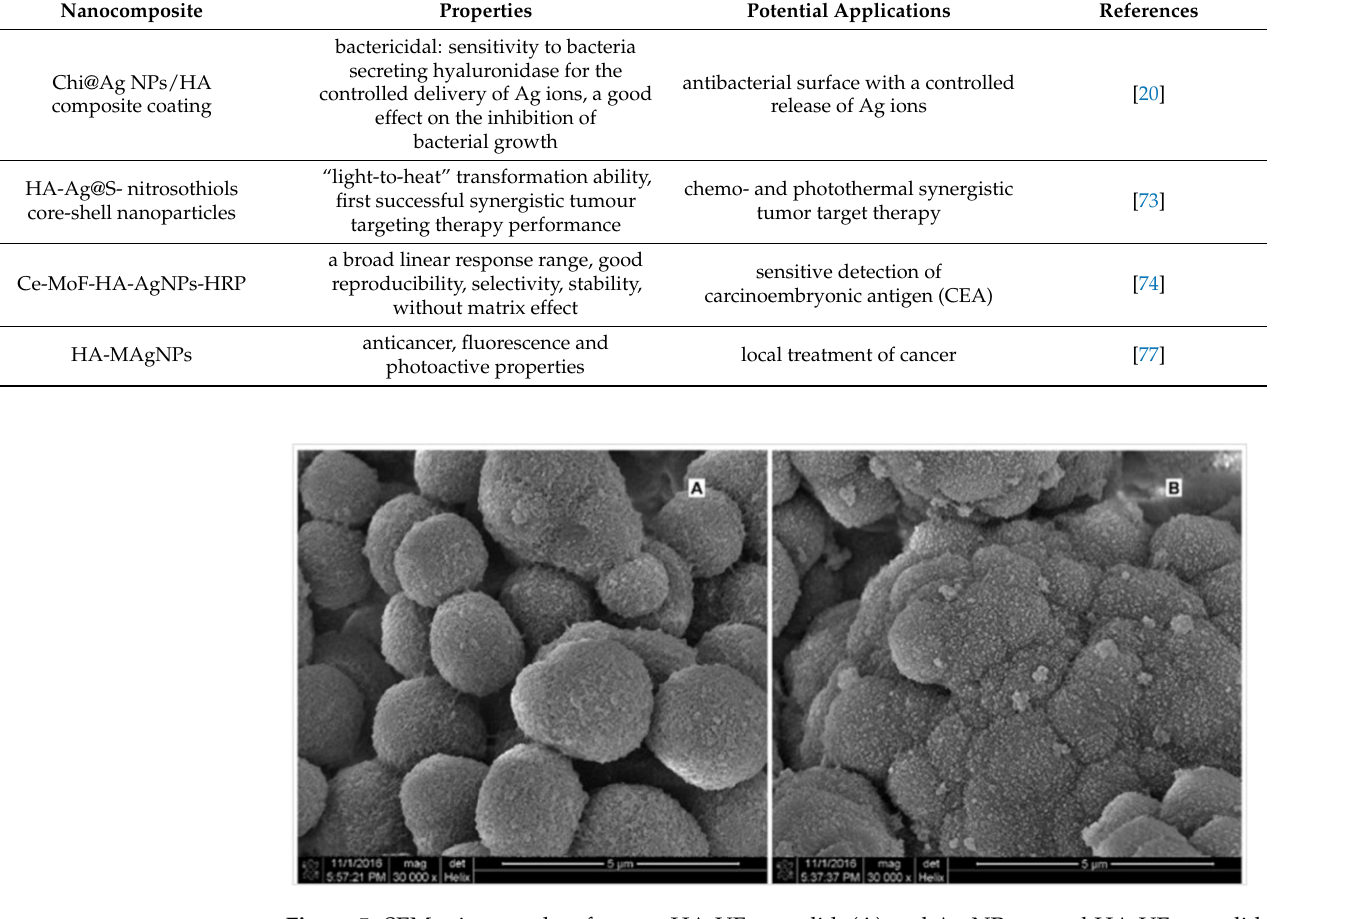
Figure 5. SEM micrographs of parent HA-UF monolith ( A ) and Ag NPs-coated HA-UF monolith ( B ). Reprinted from Reference [25] with permission from Elsevier.